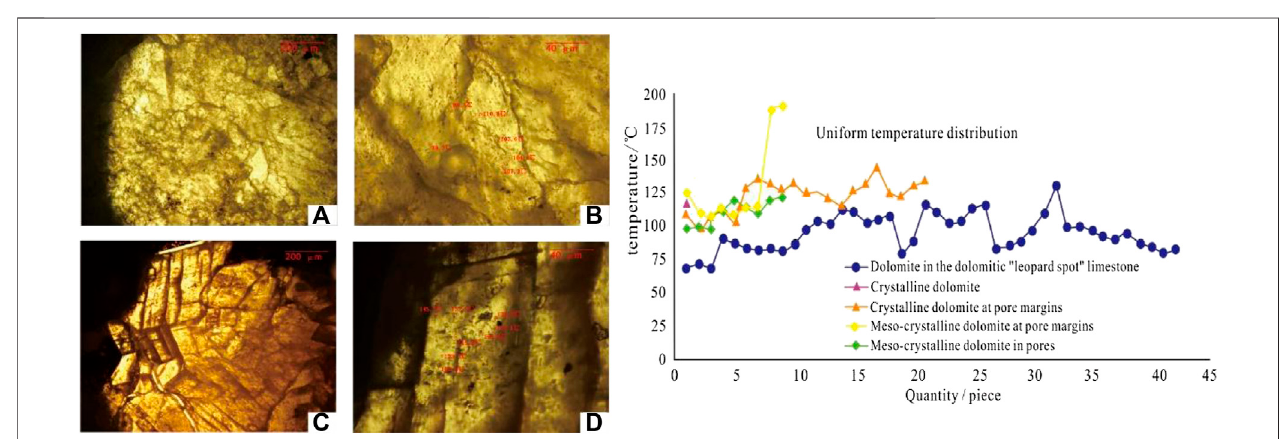
FIGURE 6 | Uniform temperature distribution of the fl uid inclusion in dolomites of the Qixia Formation in the study area. (A,B) Inclusion test points in dolomitic “ leopard-spots ” and crystalline dolomites. (C,D) Inclusion test points in holes, pores, and seam edges.